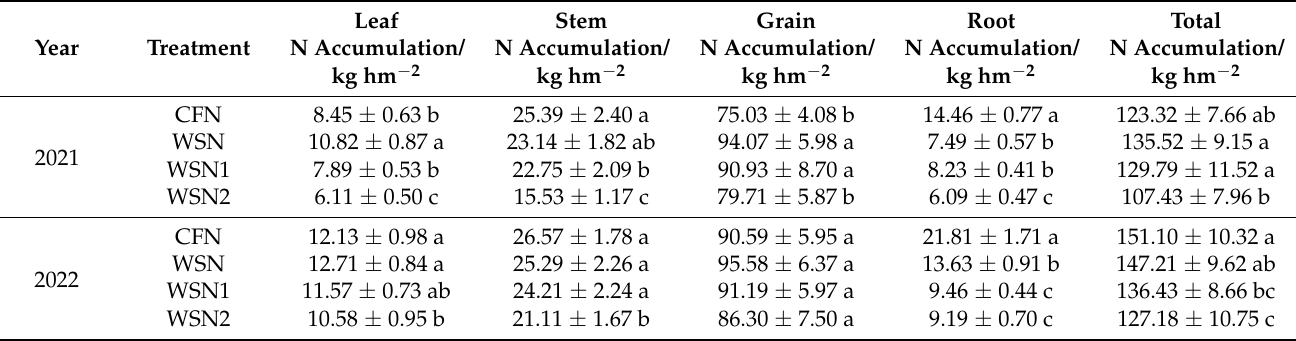
Table 3. Nitrogen accumulations of the